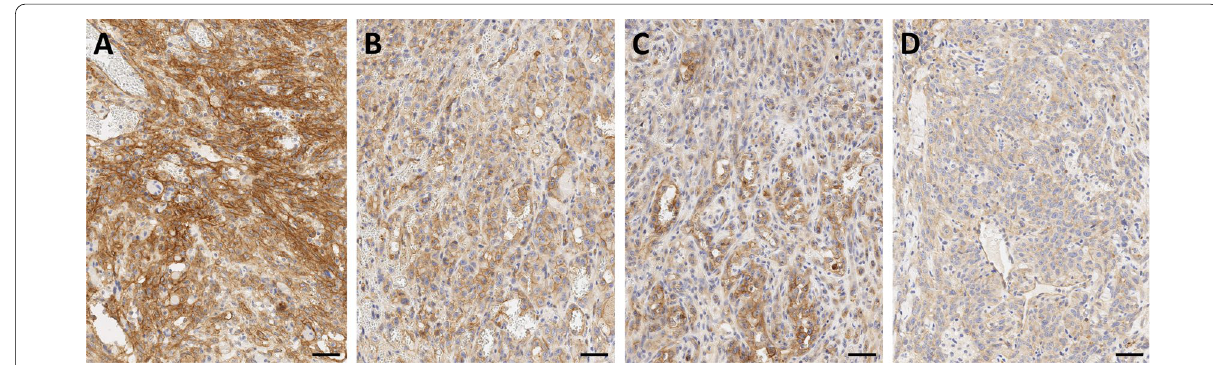
Fig. 5 α5-integrin immunohistochemistry of angiosarcoma. A high-grade ( A ), or a homogeneous ( B ) or heterogeneous ( C ) medium-grade expression was observed in 11 out of 12 specimens, and a weak expression in one ( D ). Note that the α5-subunit dimerizes only with the ubiquitous β1 (see Fig. 1), which is why α5-IHC is indicative for actual α5β1